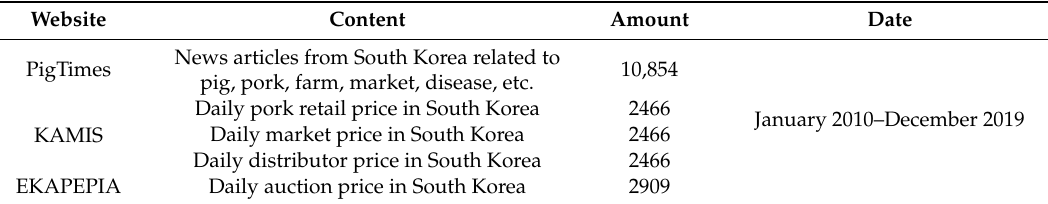
Table 2. The details of collected dataset.